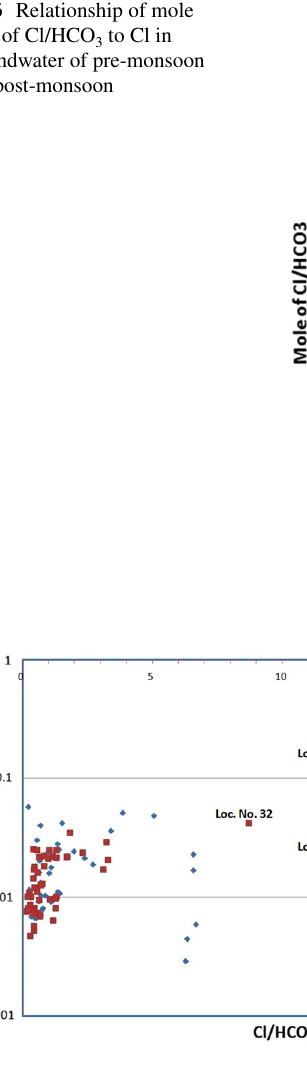
3 ratios of the